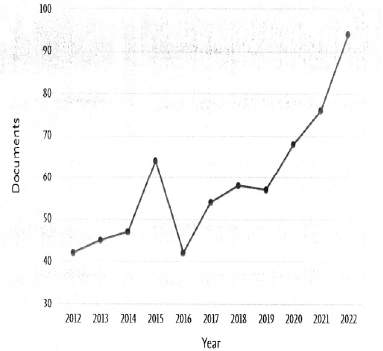
Figure 1. Scopus search for “polymerization in confinement”.